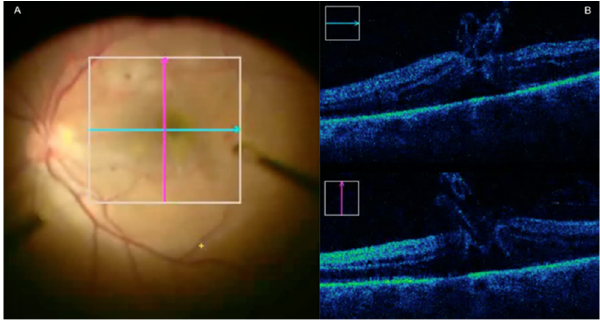
Figure 5. MI-OCT assisted Macular Hole surgery. ( A ) En-face view. ( B ) MI-OCT images confirm inverted ILM flap positioning after fluid-air exchange. Reproduced with the permission from reference [83].